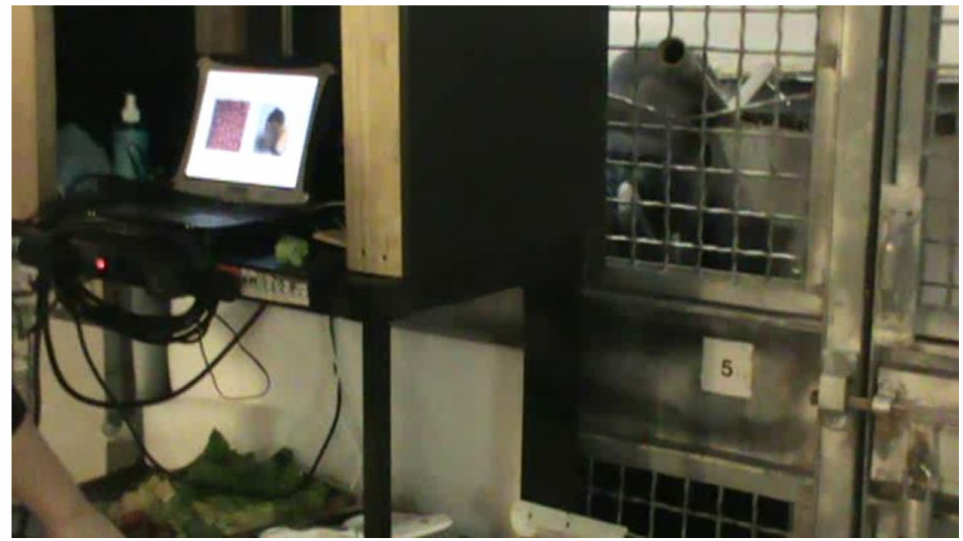
Figure 3. Kongo participating in touchscreen preference